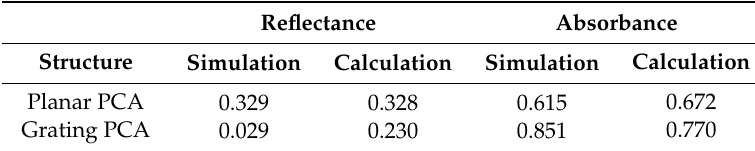
Figure 7. The refractive index of ( a ) the planar PCA and ( b ) the grating PCA structures used for Fresnel’s reflection calculation. Table 2. The optical properties of a grating PCA and a planar PCA.